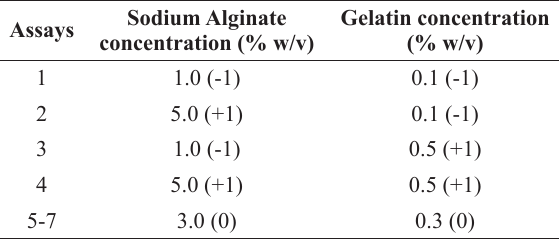
Codified levels and actual values of the variables studied in the experimental